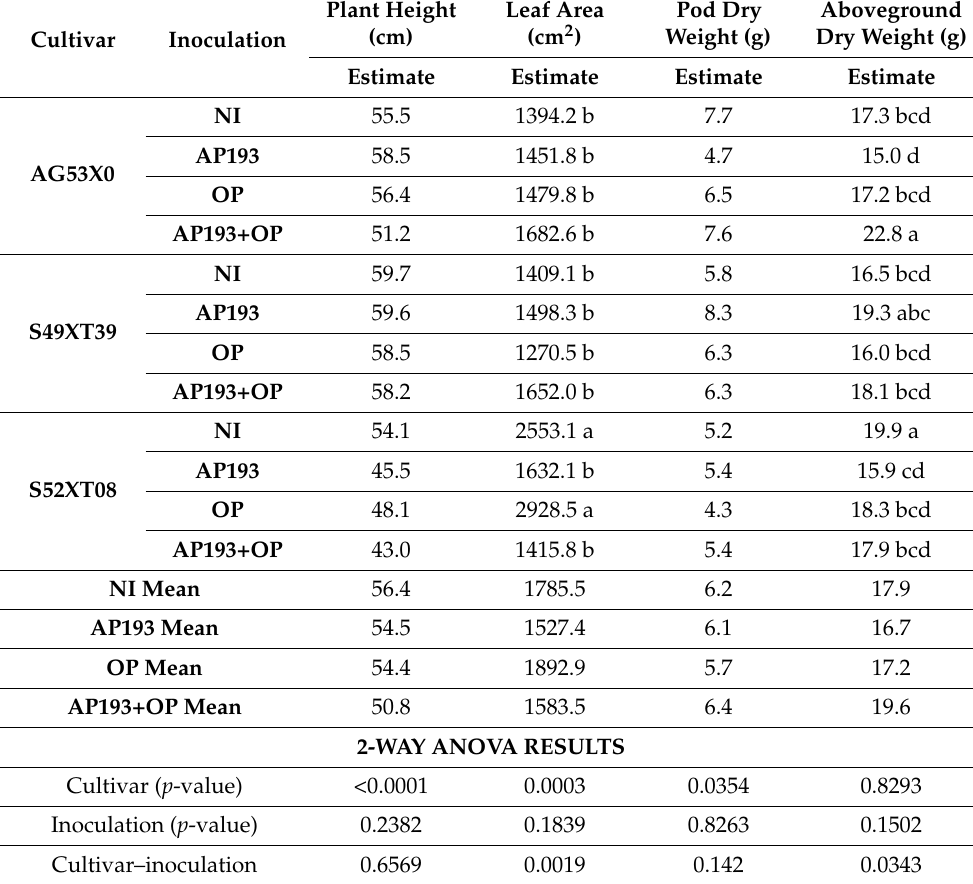
Table 4. Plant height, leaf area, pod dry weight and aboveground biomass of three soybean cultivars (AG53X0, S49XT39, S52XT08) inoculated with Bv AP193, OP alone, the combination of Bv AP193 and OP or the NI control and grown under greenhouse conditions. The bottom section of the table shows the ANOVA results ( p -value) for the effect of cultivar, inoculation, and the interaction cultivar–inoculation. Different letters indicate significant differences within the treatment